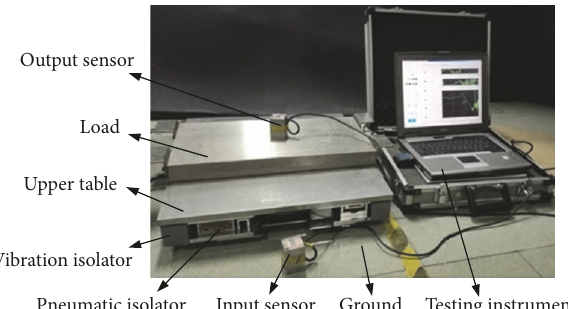
Figure 12: Photograph of experiment 1.